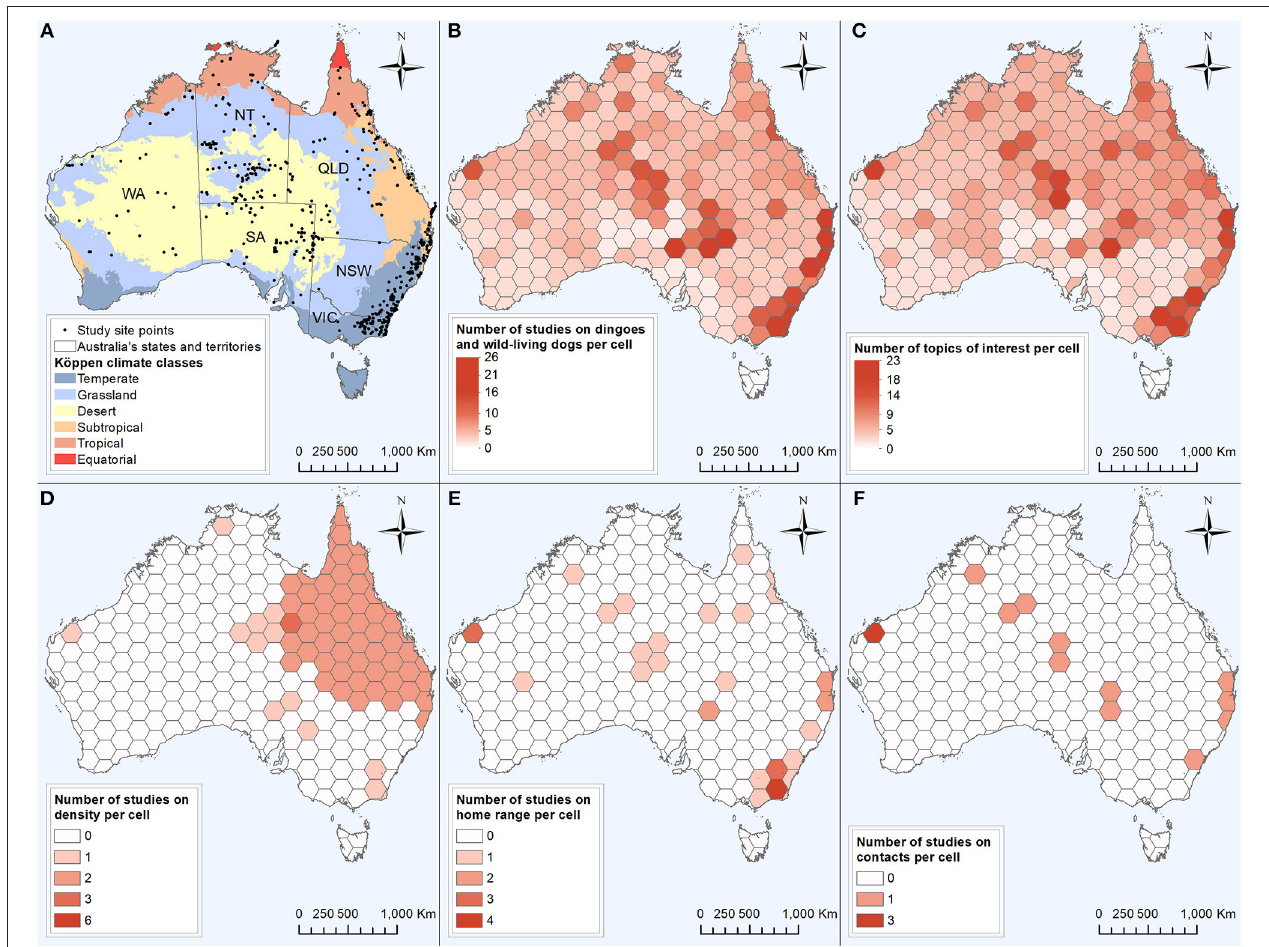
FIGURE 6 | Six maps based on 229 studies captured from a scoping review on the ecology and biology of dingoes, feral domestic dogs, and dingo-dog hybrids in Australia, targeting 28 specific topics of interest selected to inform disease spread models. Colour intensity is proportional to the number of studies conducted (B,D–F) or the number of topics of interest reported out of the 28 selected topics of interest (C) within the cell. (A) Distribution of 768 site points in which data of interest on dingoes and wild-living dogs in Australia was collected, in relation to the Köppen climate major classes (WA, Western Australia; NT, Northern Territory; SA, South Australia; QLD, Queensland; NSW, New South Wales; VIC, Victoria). (B) Distribution of studies on dingoes and wild-living dogs in Australia. (C) Distribution of reported topics of interest (D) Distribution of studies investigating the topic of interest density or population size. (E) Distribution of studies investigating the topic of interest home range. (F) Distribution of studies investigating the topic of interest contacts or interactions between dingoes and/or wild-living dogs.